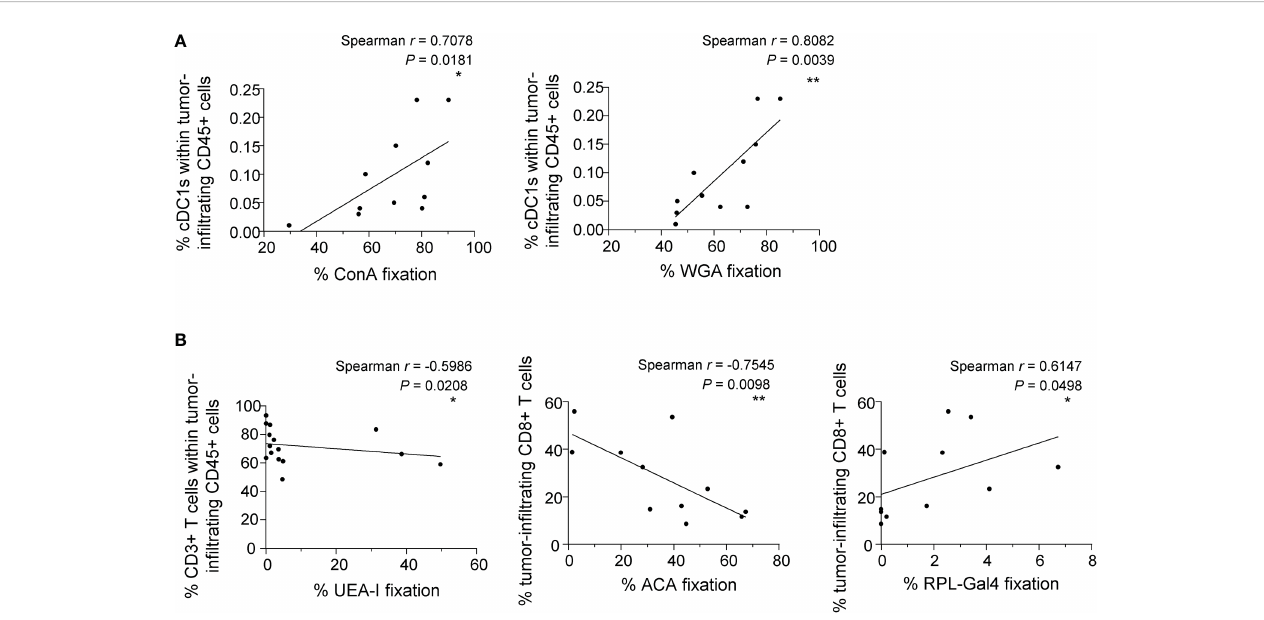
FIGURE 7 The tumor glyco-code correlates with the nature and magnitude of the immune in fi ltrate. Proportions of tumor-in fi ltrating CD45, cDC1s, CD3 and CD8 T cells were evaluated by fl ow cytometry on the same patients ’ tumor samples from whom the glyco-code of derived primary tumor cell lines was performed. Spearman correlation were performed to assess the link between the tumor glyco-code and immune cell in fi ltration. (A) Spearman ’ s correlation of frequencies of ConA (left panel) or WGA (right panel) interaction with tumor cells lines derived from melanoma patients and proportions of tumor-in fi ltrating cDC1s within CD45 + cells (n=11). (B) Spearman ’ s correlation of frequencies of UEA-I (left panel), ACA (middle panel) or RPL-Gal4 (right panel) binding by tumor cell lines derived from melanoma patients and proportions of tumor-in fi ltrating CD3 + or CD8 + T cells (n = 11 to 15). *P-value ≤ 0.05, **P-value ≤